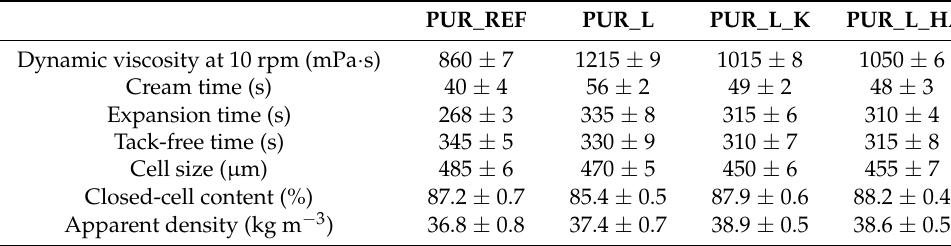
Figure 3. SEM images of lavender fillers: ( a , b ) Non-functionalized lavender, ( c , d ) lavender functionalized with kaolinite, ( e , f ) lavender functionalized with hydroxyapatite. Table 2. Rheological and structural properties of PUR composites.